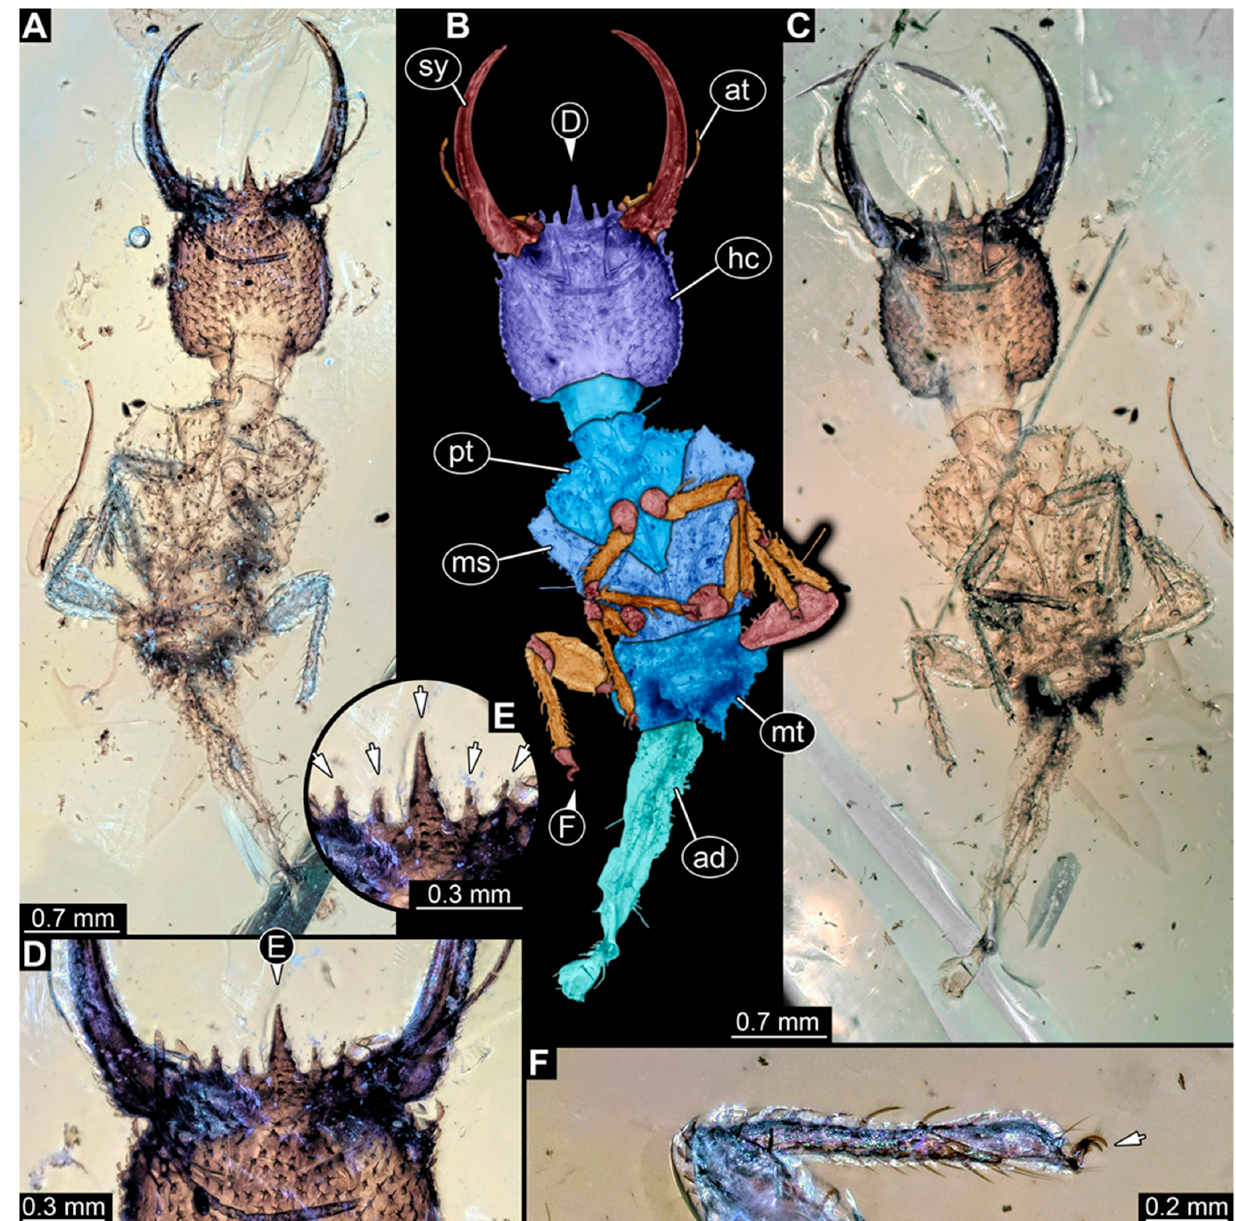
Figure 3. Specimen 56 (PED 0379); Myanmar amber. ( A ) Dorsal view. ( B ) Ventral view, colour- marked. ( C ) Ventral view. ( D ) Close-up of anterior head region. ( E ) Close-up of labrum in dorsal view; arrows mark spine-like protrusions. ( F ) Close-up of third locomotory appendage; arrow marks claw. Abbreviations: ad = abdomen; at = antenna; hc = head capsule; ms = mesothorax; mt = metathorax; pt = prothorax; sy = stylet.